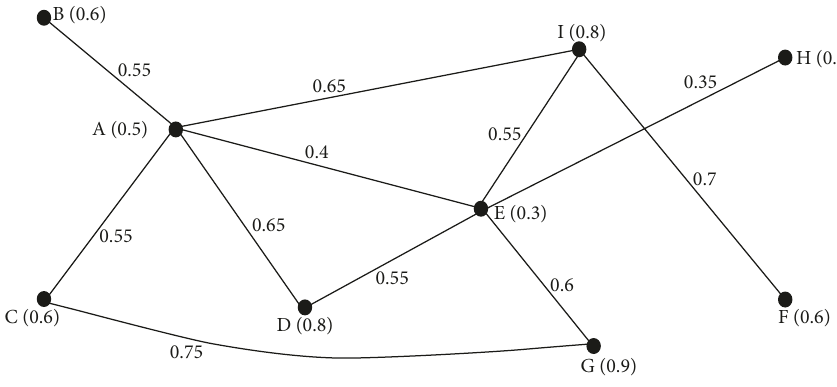
Figure 1: A generalized fuzzy graph. Table 4: Centrality of all vertices of Figure 1. Vertex